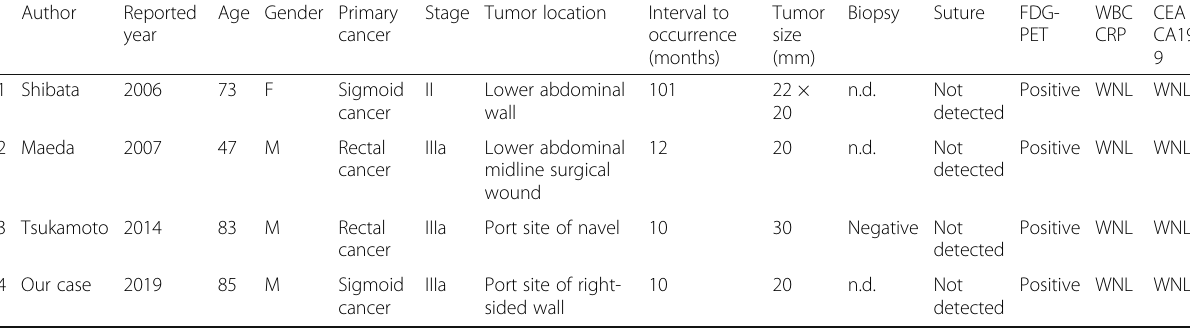
Table 1 Previous reports of Schloffer tumor at abdominal operative scar in patients who underwent colorectal